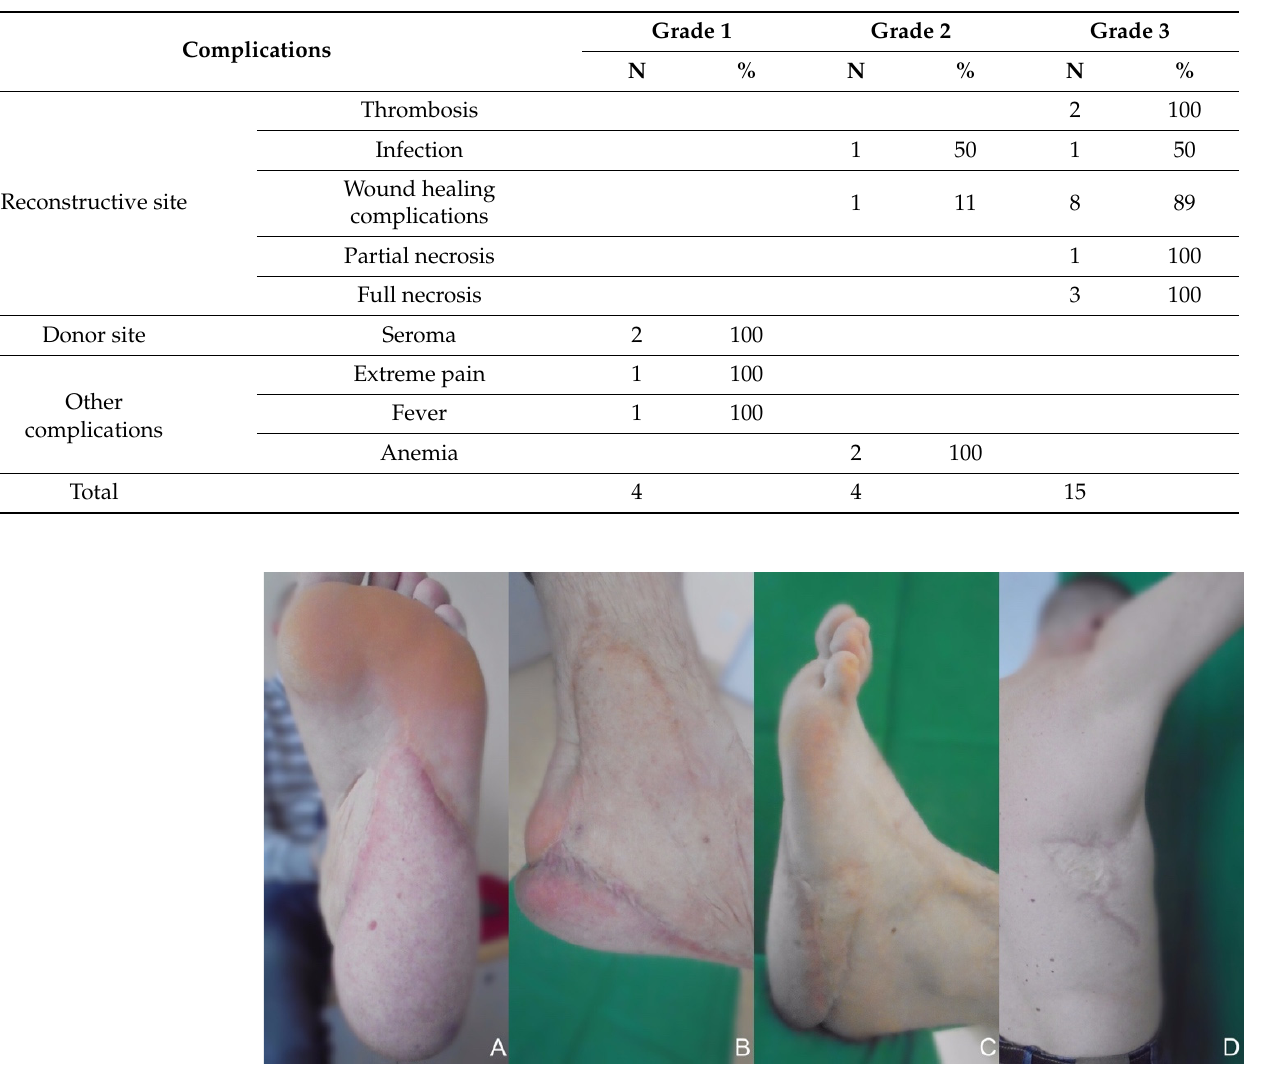
Figure 2. Healed donor and recipient site 20 years after reconstruction at a follow-up meeting. ( A ) Inferior view. ( B ) Medial view. ( C ) Lateral view. ( D ) Donor site.